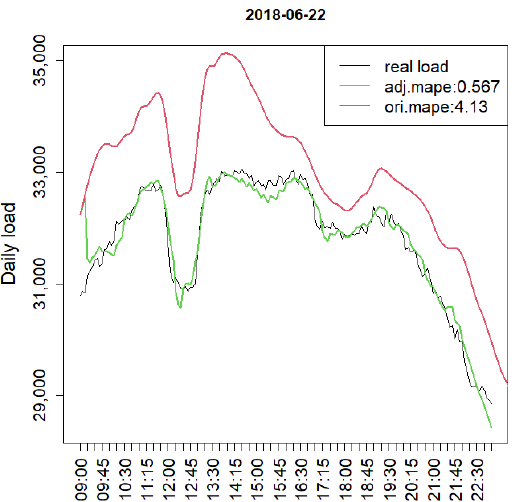
Figure 6. Actual Load and Forecasts for 22 June 2018 by the RTLF and RNN Models, with 5 Mi- nute Intervals.